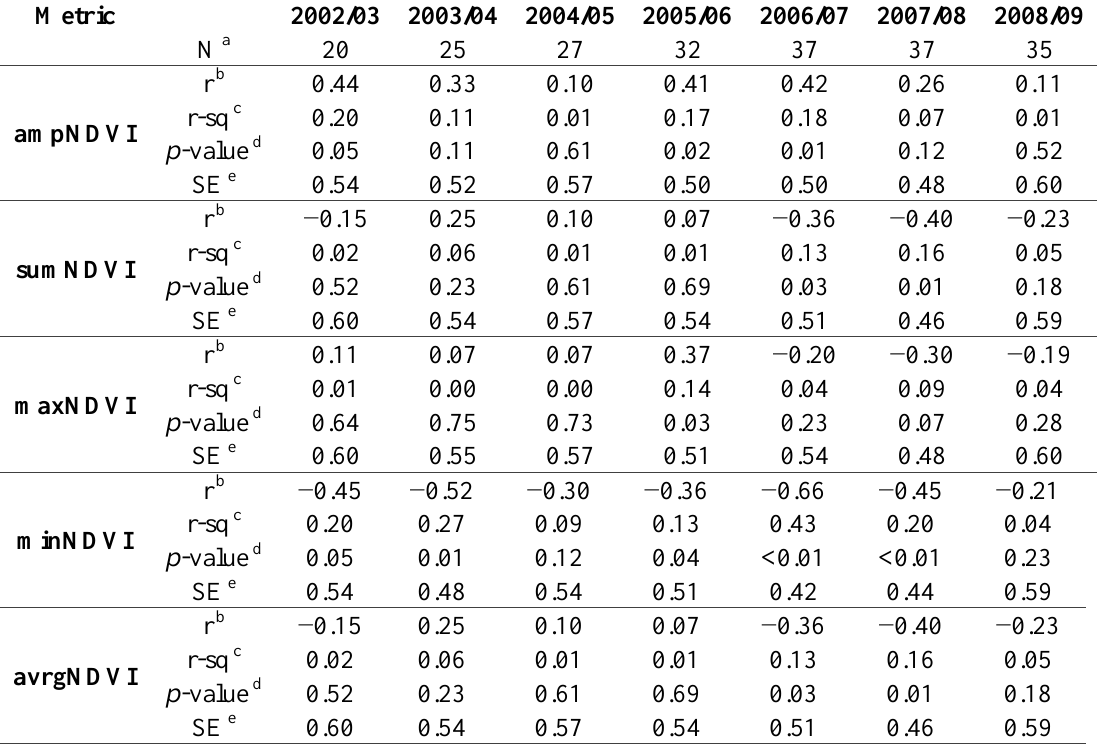
Table 3. Correlation coefficients between variation on coffee yield and variation on NDVI metrics in the same year for each metric